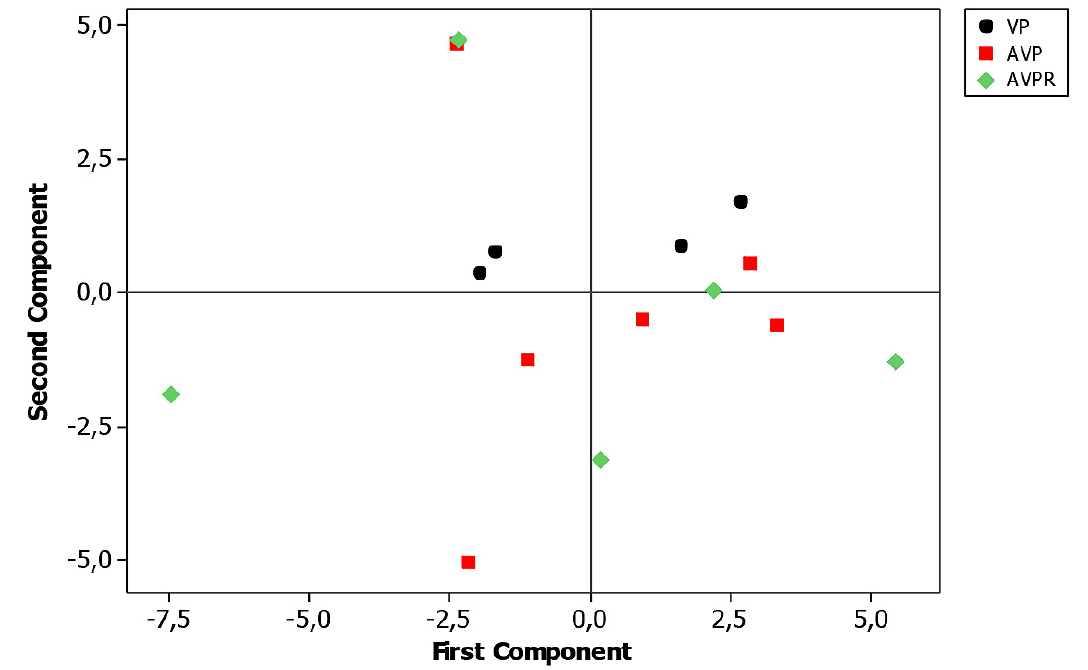
Figure 3. Principal component analysis of δ 13 C and δ 15 N values from experimental day zero to 46.